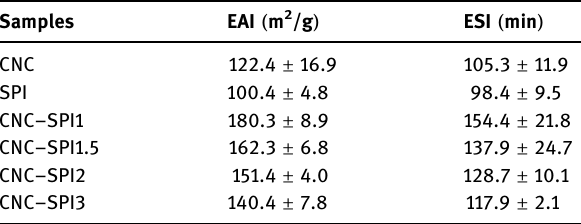
Table 1: : The emulsifying properties ( EAI and ESI ) for the emulsions stabilized by CNC, SPI, and CNC – SPI nanoconjugates